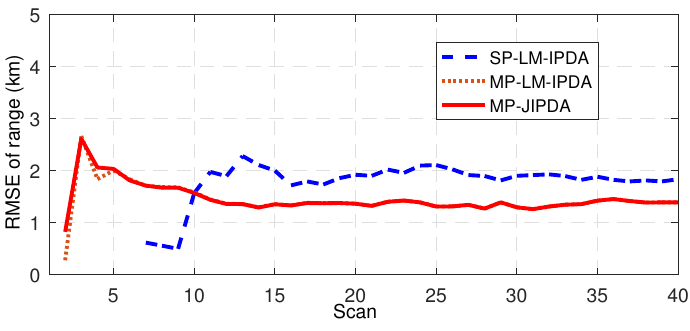
Figure 13. RMSE of range for Target 3.